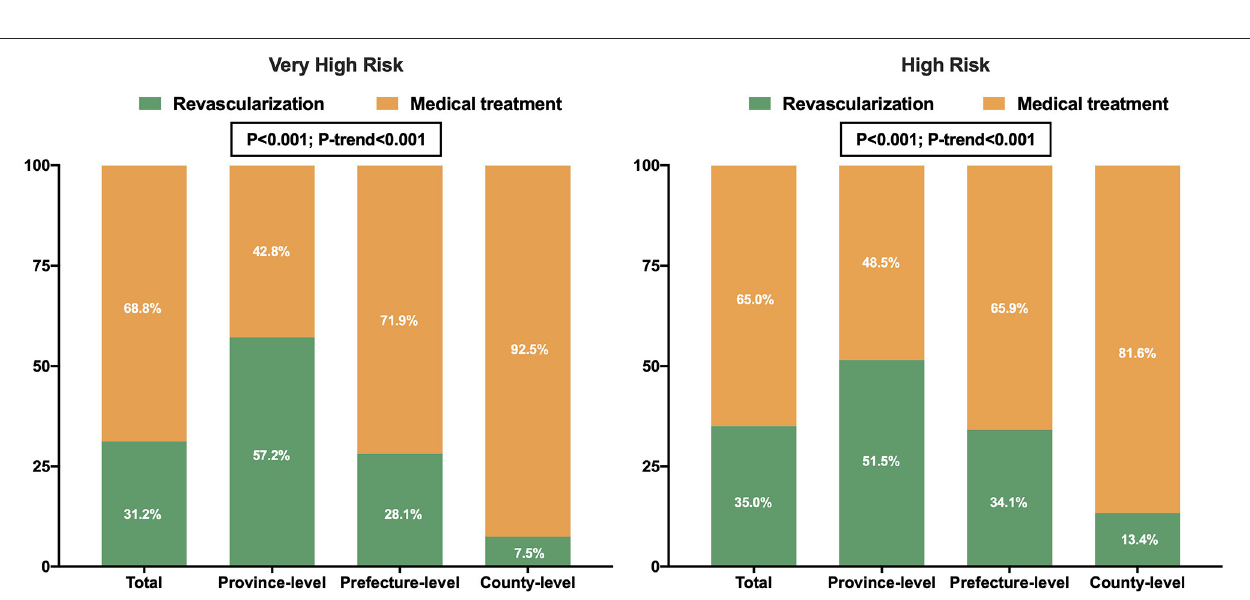
FIGURE 2 | Utilization and timing of invasive strategies in patients with NSTEMI according to the guideline-recommended risk criteria among the three hospital levels in China.